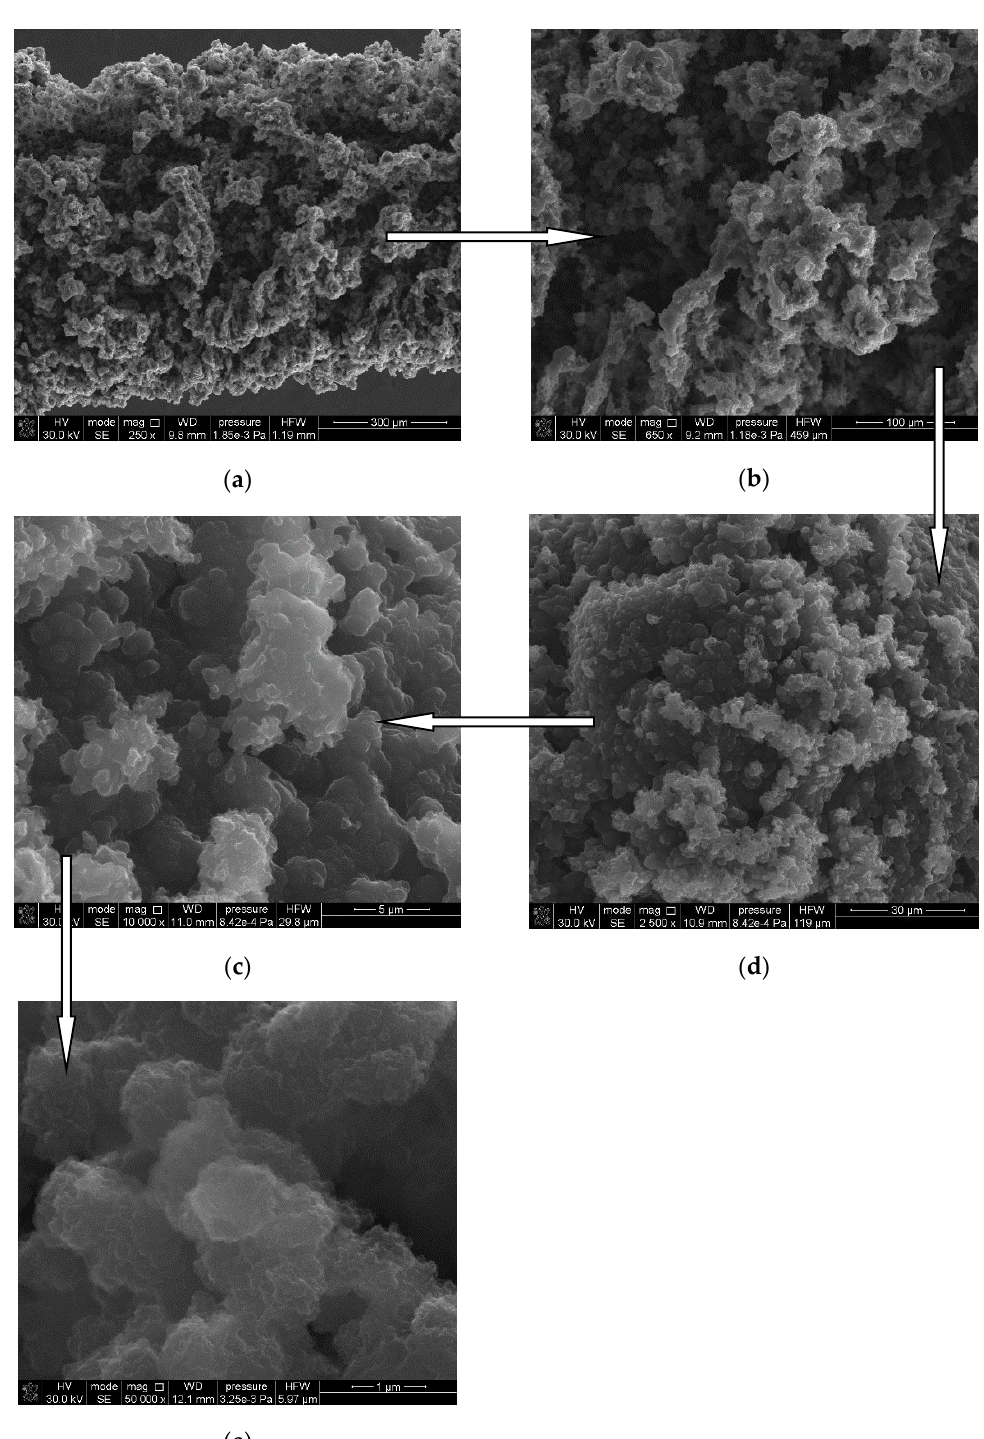
Figure 5. Structure and morphology of the surface of the sorption polythiophene MIP-SPME fiber under a transmission electron microscope (for MET).